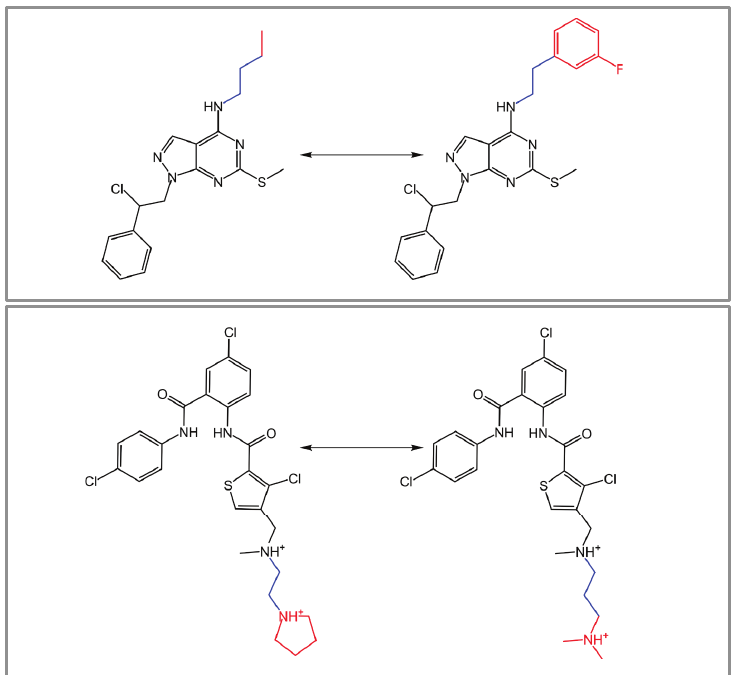
Figure 4. Standard MMPs vs. RECAP-MMPs. Two pairs of compounds that form both standard MMPs and RECAP-MMPs are shown. For each pair, the structural differences between compounds are highlighted. The chemical transformation associated with the standard MMP is colored in red, while the transformation of the RECAP-MMP corresponds to the combination of fragments colored in red and blue.